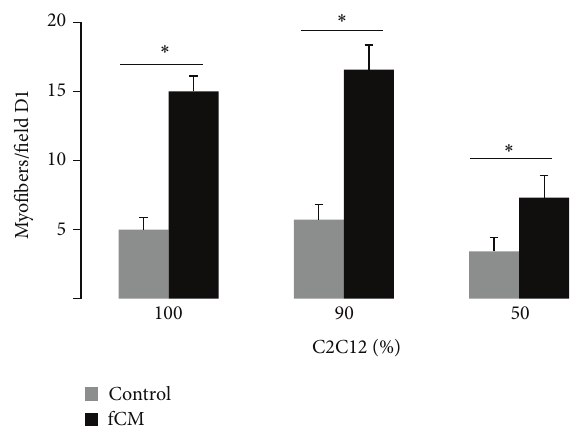
Figure 1: Myofiber density in C2C12/Nor-10 tissue sheets with varied initial cell concentration; 100% C2C12 with 0% Nor-10, to 90% C2C12 with 10% Nor-10, to from 50% C2C12 with 50% Nor-10. Bars show 𝑛 = 8 tissue sheets per group. “ ∗ ” statistically significant between the indicated pairings, 𝑃 < 0.05